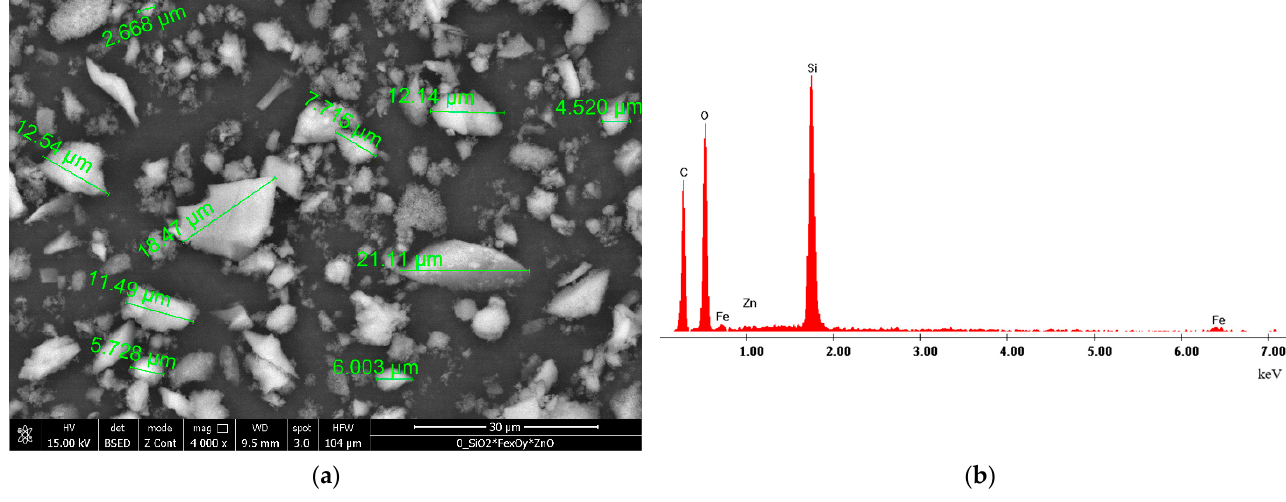
Figure 1. Scanning electron microscopy (SEM) ( a ) ş i X-ray dispersive energy spectroscopy (EDX) ( b ) for SiO 2 FexOy material.